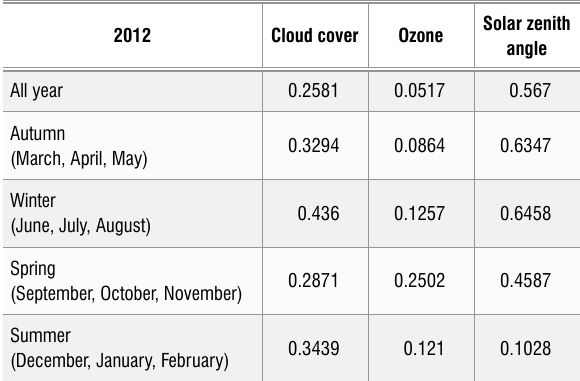
R 2 -values for the relationships between solar ultraviolet radiation and cloud cover, total column ozone and solar zenith angle for each season of 2012 and for the entire year